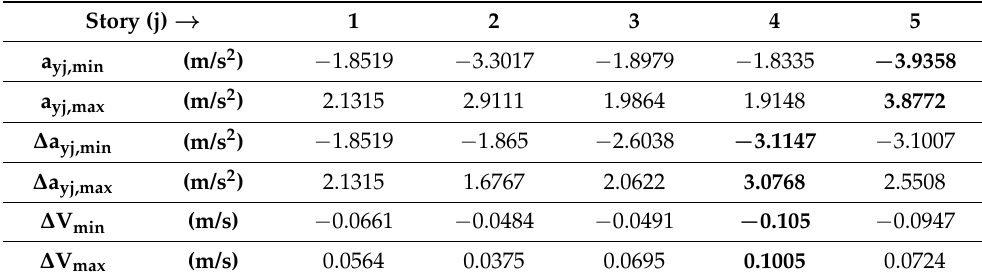
and minimum values in